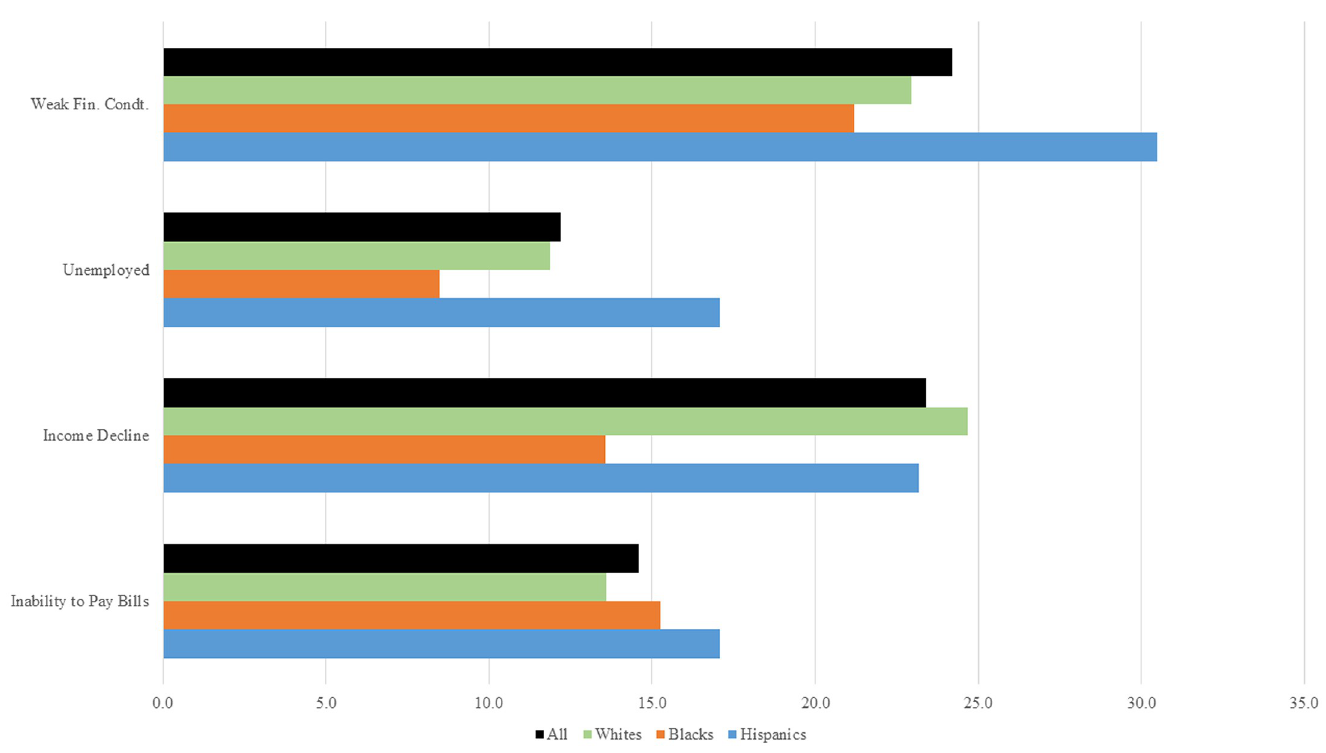
Fig 1. Percentage deprived in each indicator. Source: Authors calculations using SHED, April 2020, data. All percentage values are calculated using sample weights.